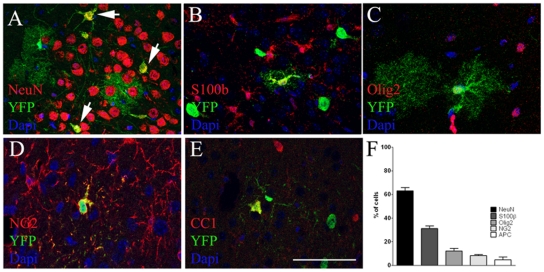
Embryonic AspM descendants give raise to neuronal and glial cell lineages in the adult brain.P30 coronal sections of AspM-CreERT2/Rosa26YFP double transgenic mice (n = 4) injected with Tam at the embryonic stages of E12.7 and E13.2 were assayed for YFP detection in the cerebral cortex. Cell counts were performed in a region encompassing the anterior bregma +1.2 and the posterior bregma −0.5. 63.1% (±2.8) of YFP+ cells in the cortex expressed NeuN (A, F), 31.3% (±2.1) expressed S100β (B, F), 12.2% (±0.8) Olig2 (C, F), 8.3% (±0.8) NG2 (D, F) and 4.7% (±2.5) CC1 (E, F). Percentages (±S.D.) are show in histogram plotted in panel F. Scale bar 100 µm.